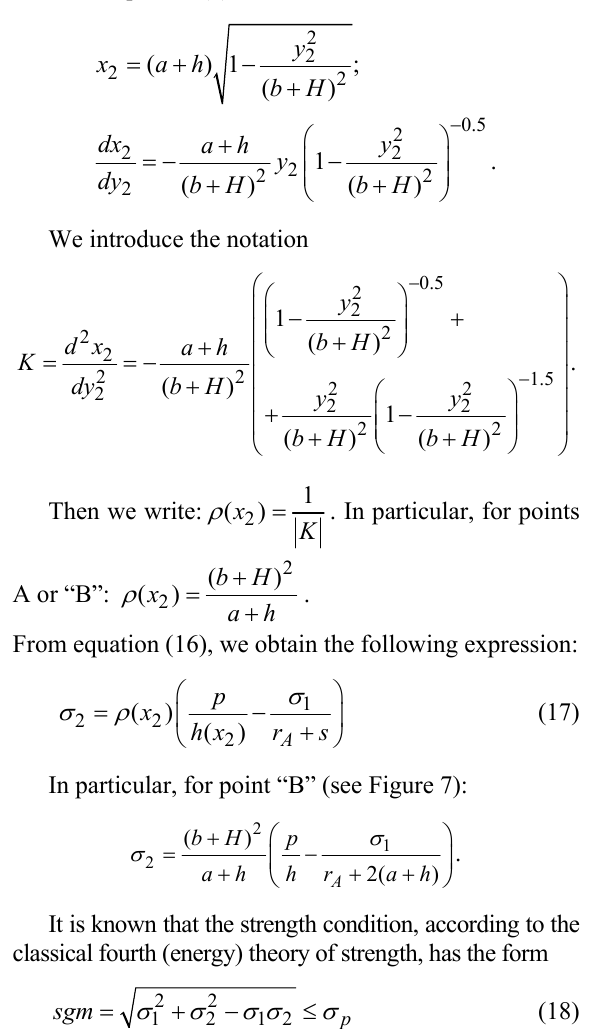
Figure 8. Moving point "B" of the camera section (see Figure 7) in the radial direction depending on chamber